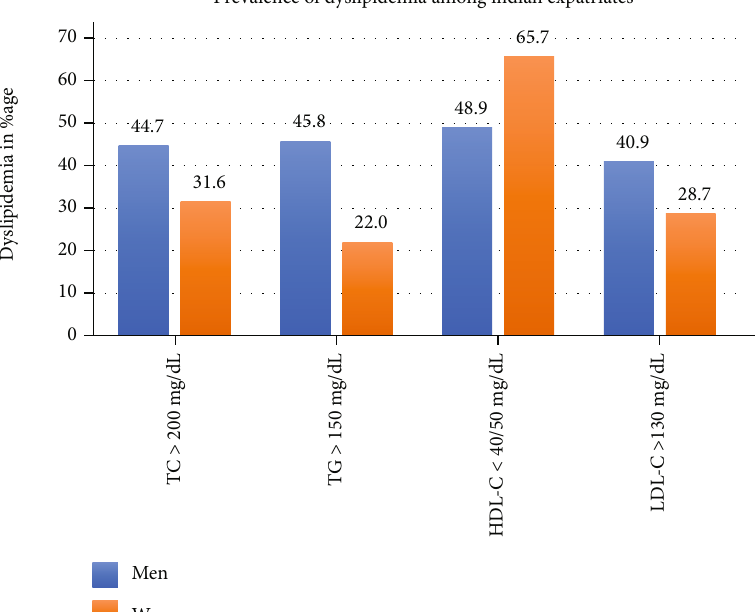
Figure 2: Prevalence of dyslipidemia. Prevalence of various dyslipidemias among Indian expatriates in Qatar: prevalence of dyslipidemia for total cholesterol, triglycerides, and low-density lipoprotein cholesterol is higher in men, while the prevalence for high-density lipoprotein cholesterol dyslipidemia is signi fi cantly higher in women ( p value